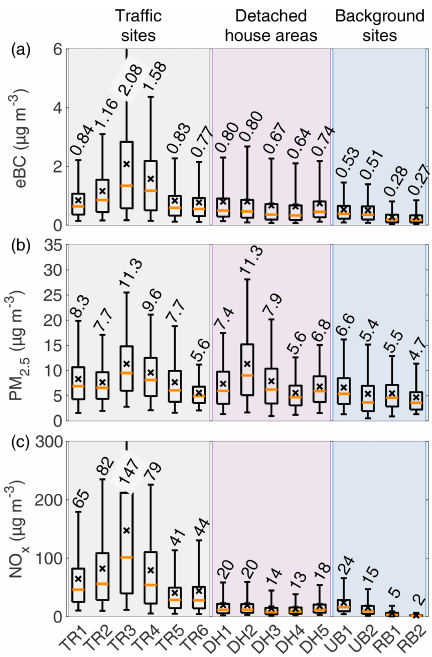
Figure 2. Statistics of the (a) eBC, (b) PM 2 . 5 , and (c) NO x con- centrations at each station. The boxplots are presented for 1 h mean values. The orange line in the middle of each box represents the me- dian, the edges of the boxes represent the 25th and 75th percentiles, and the whiskers represent the 5th and 95th percentiles. The black cross is the arithmetic mean, and its numerical value is reported above each box. The background color represents the station type: gray for traffic sites (TRs), purple for the detached housing sites (DH), and blue for the background sites (UB for urban and RB for regional background). The 75th percentiles of the eBC and NO x concentration at TR3, which are not visible at the figure, were 6.7 and 440µgm − 3 ,